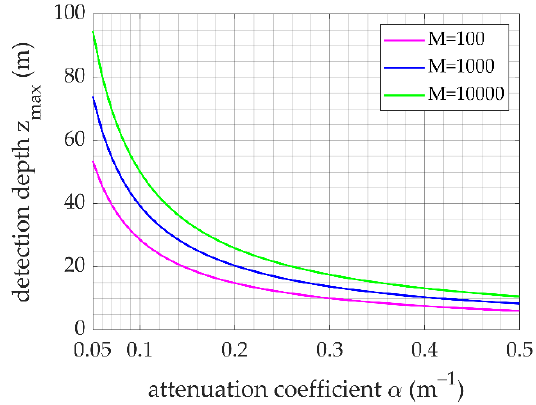
Figure 13. Maximum detection depth for different attenuation coefficients.